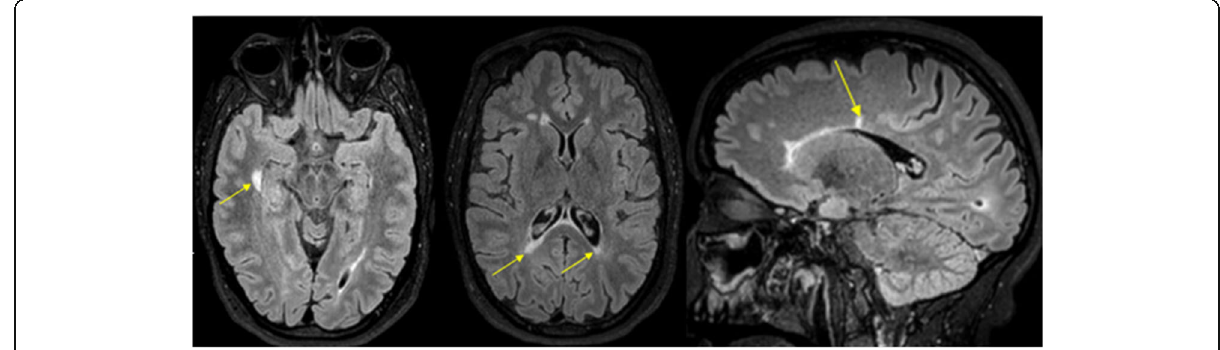
Fig. 3 Axial and sagittal 3D FLAIR sections showing periventricular white matter lesions abutting the lateral ventricles with no white matter in